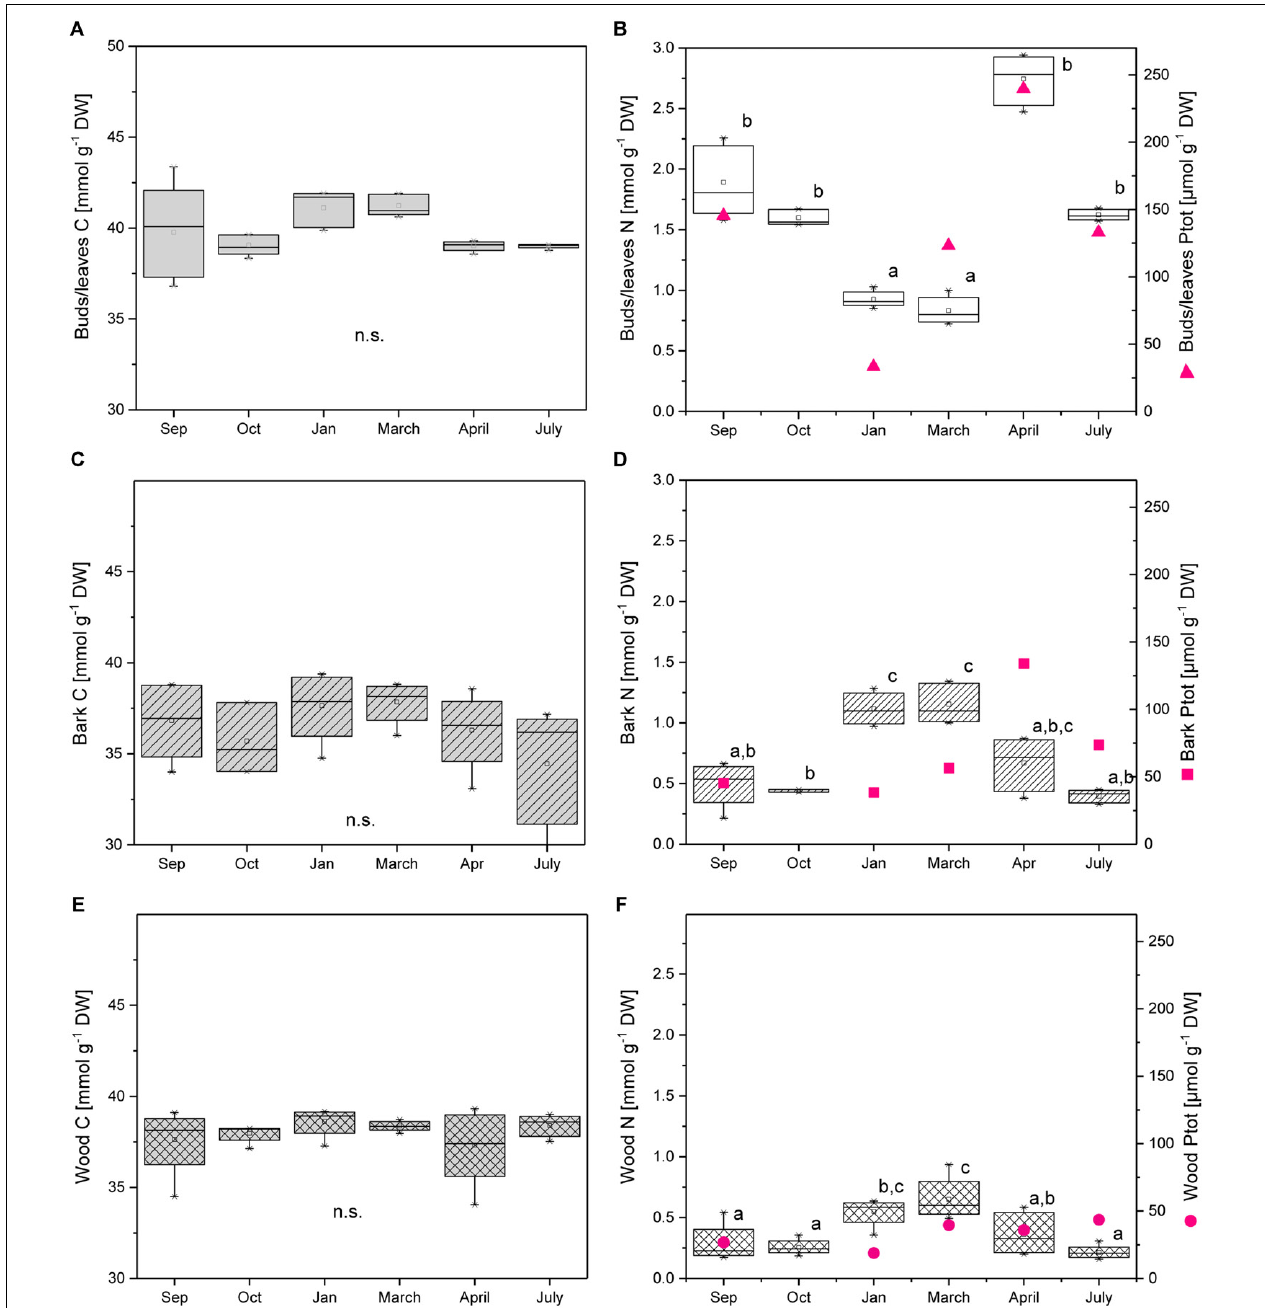
FIGURE 1 | Total C, N, and P in buds/leaves, bark, and wood of adult poplar trees. Box plots of total C (A , C , E) , total N (B , D , E) , and total P ( magenta dots , B , D,F ) in poplar buds/leaves (A , B) , twig bark (C , D) , and wood (E , F) . Data of total P were taken from Netzer et al. (2018b). Lower case letters represent significant differences between seasons determined by one way ANOVA followed by the post hoc tests Bonferroni and Tukey’s ( P < 0.05) per tissue (Sep = 09/26/2013; Oct = 10/02/2013; Jan = 01/22/2014; March = 03/27/2014; April = 04/16/2014; and July =